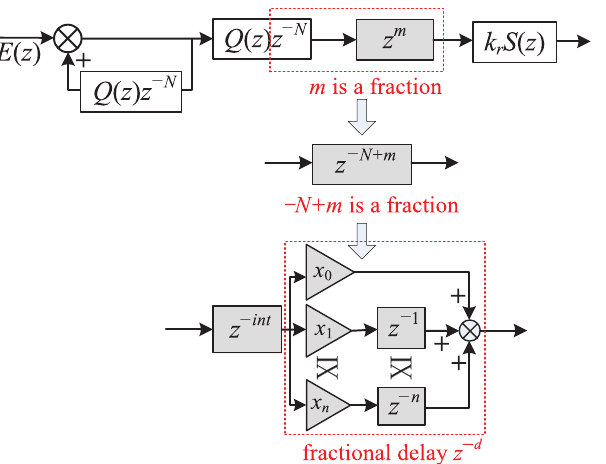
Figure 2. Structure of the FO-PIMR-RC with fractional-order phase lead